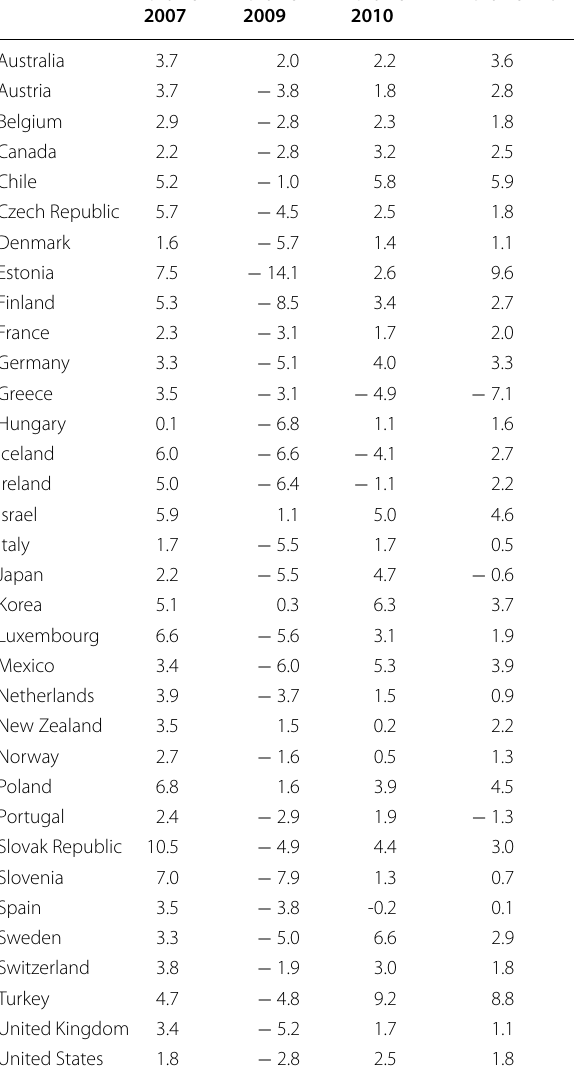
Table 5 Gross domestic product, volume, annual growth rates in percentage. Source: National Accounts at a Glance 2014, OECD, 2014.